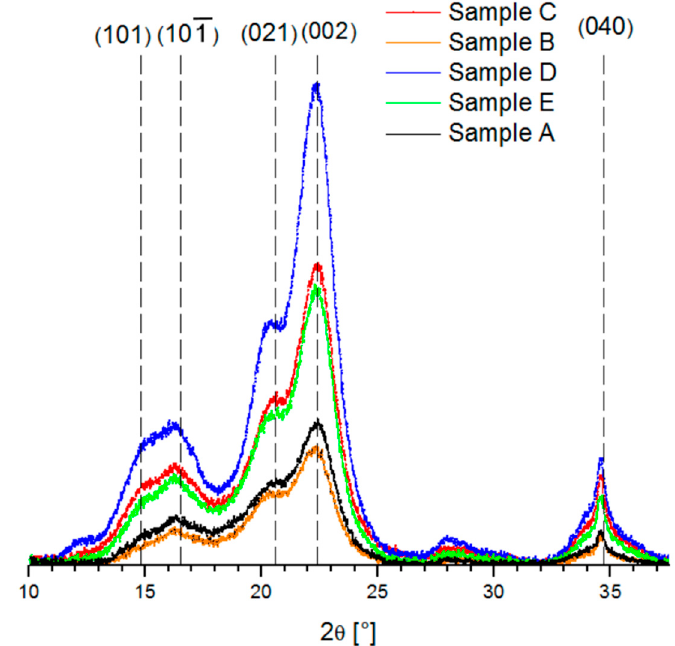
Figure 4. XRD spectra showing of the crystalline peaks associated with the five CNCs samples analyzed.